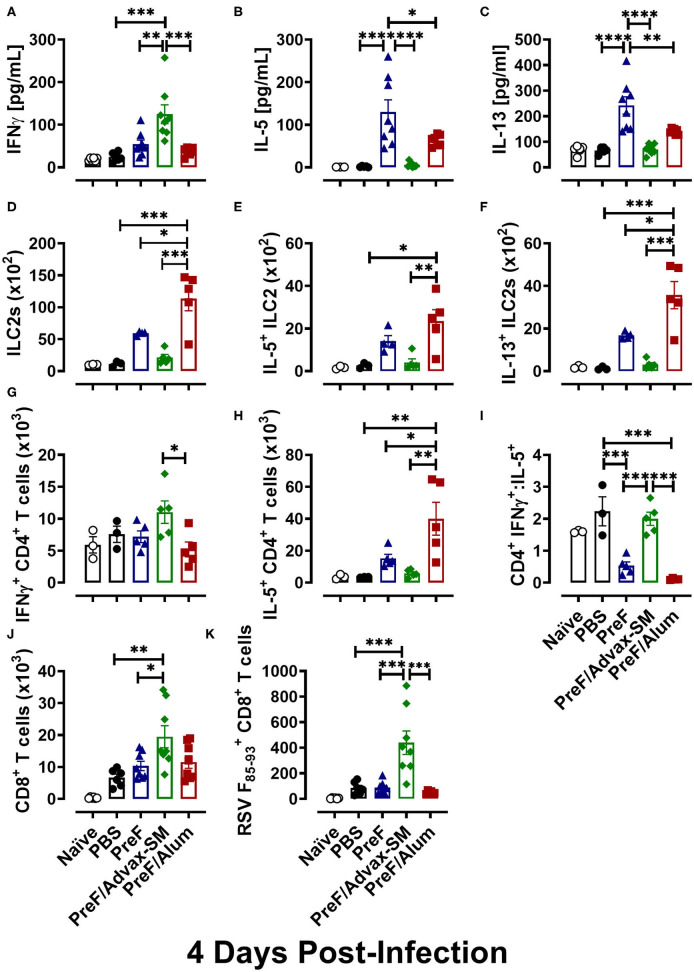
PreF/Advax-SM immunization produced Th1-dominant immunity with increased RSV F-specific CD8+ T cells. At 4 dpi, first wash samples were harvested from the airways for quantification of IFNγ (A), IL-5 (B), and IL-13 (C) by Luminex. Right lungs were harvested and homogenized for quantification of ILC2s (D) and ILC2 intracellular cytokine staining of IL-5 (E) and IL-13 (F) by flow cytometry. Intracellular production of IFNγ (G) and IL-5 (H) by CD4+ T cells from lung homogenate were quantified by flow cytometry and the ratio of IFNγ/IL-5-producing CD4+ T cells was calculated (I). Total CD8+ T cells (J) and RSV F85−93-specific CD8+ T cells (K) were measured from BAL. Data are represented as mean ± SEM (n = 6–8 mice per group);*p < 0.05, **p < 0.01, ***p < 0.001, and ****p < 0.0001.